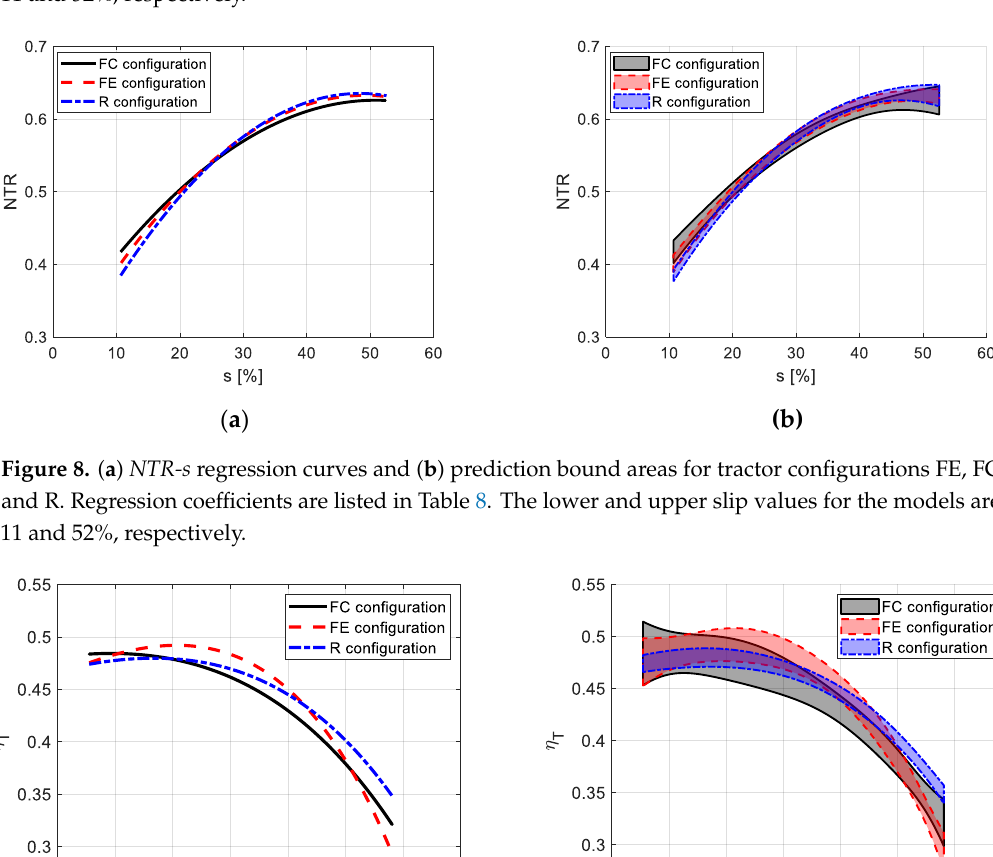
Table 8. Coefficient values for the NTR-s regression model (R2).